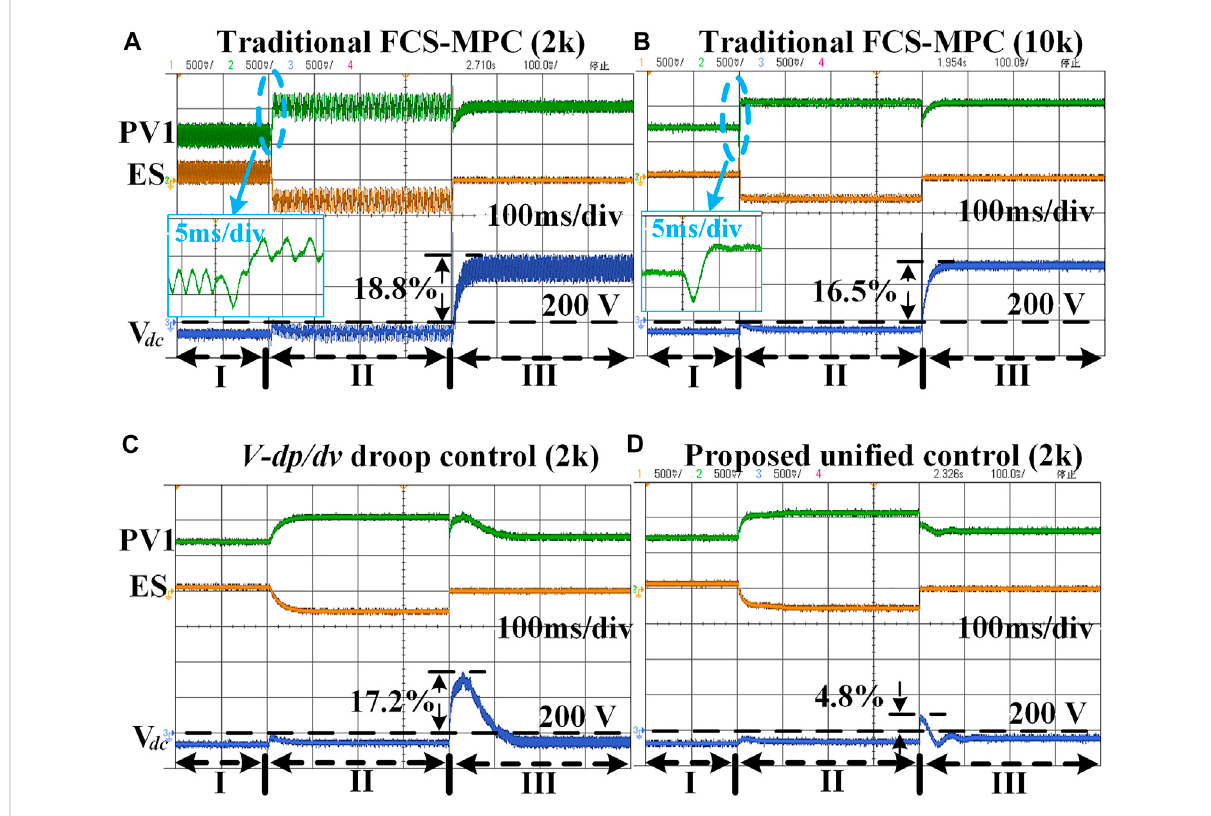
FIGURE 10 Comparisons of the MPPT and voltage regulation dynamic responses with different control methods for PV1. (A) Traditional MPC with a 2 kHz sampling frequency. (B) Traditional MPC with a 10 kHz sampling frequency. (C) Uni fi ed control based on V − dp / dv droop control with a 2 kHz sampling frequency. (D) Proposed uni fi ed control with a 2 kHz sampling frequency.